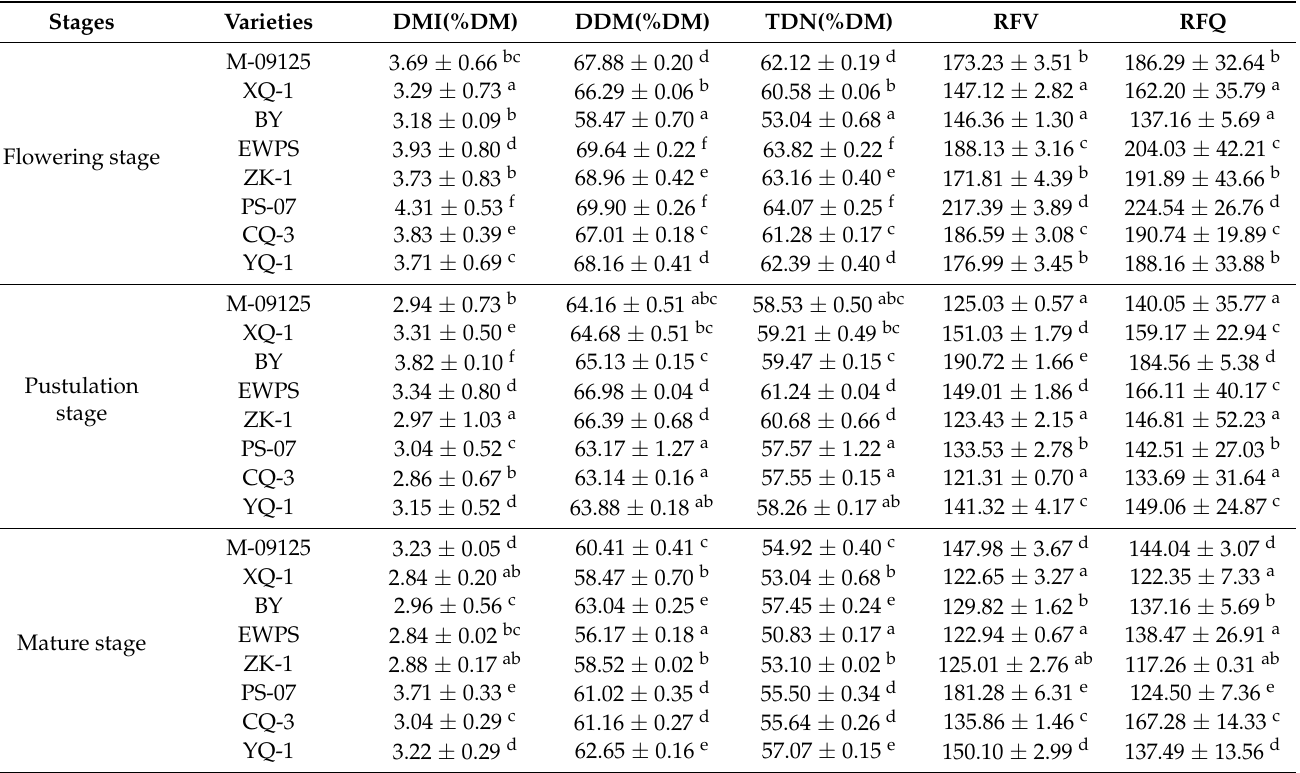
Table 2. The dry matter intakes, digestible dry matter, total digestible nutrients, relative feed value and relative forage quality of eight tartary buckwheat varieties at different growth